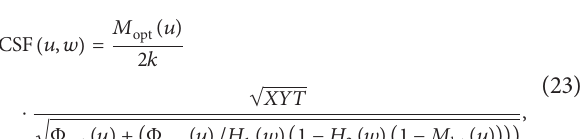
(19), and (21), but these models were not based on direct measurements of these parameters: they were based on CSF of the physiological